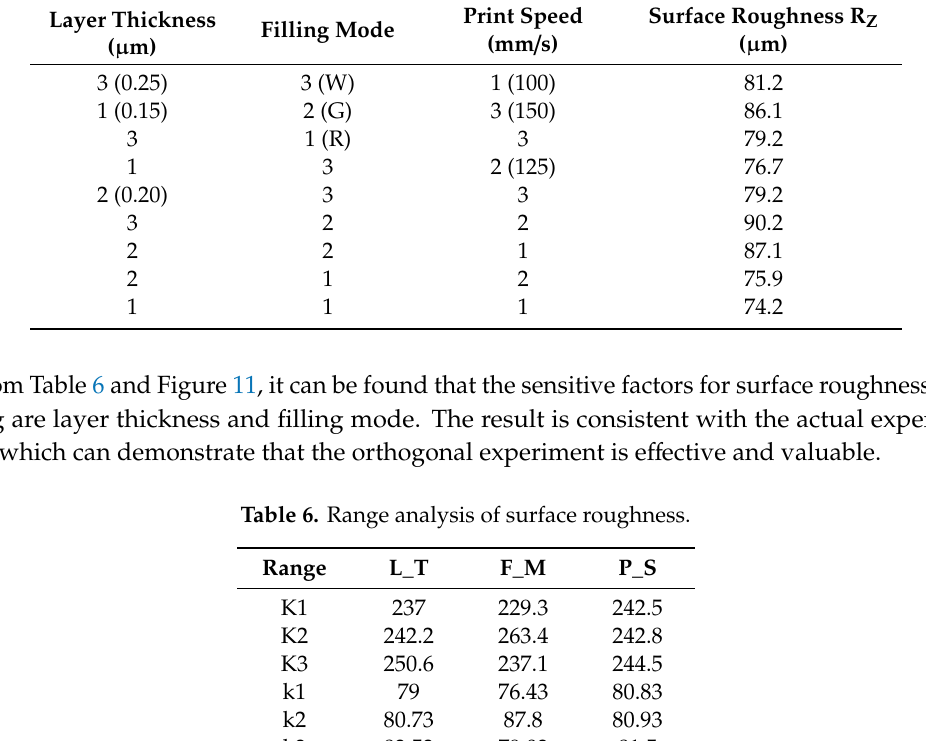
Table 5. Orthogonal test table of surface roughness measurement.